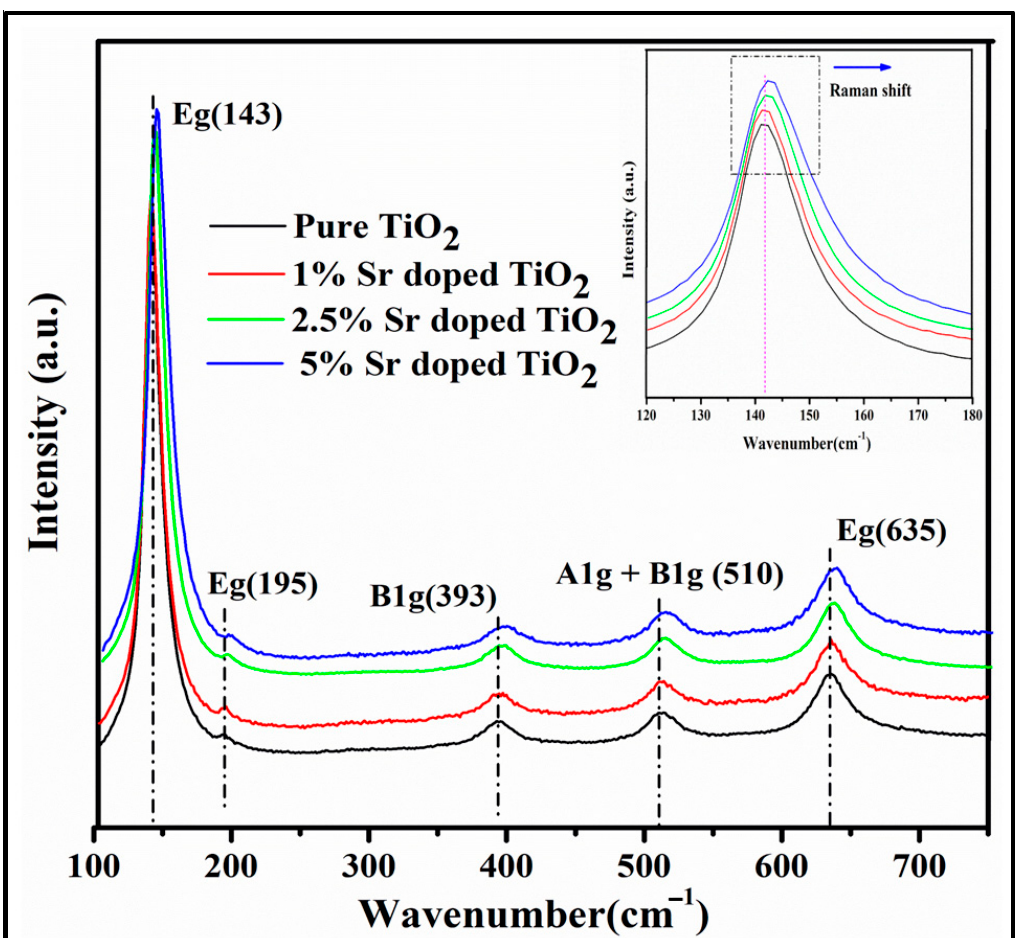
Figure 7. Raman spectra of pristine TiO 2 and Sr-doped TiO 2 nanoparticles.